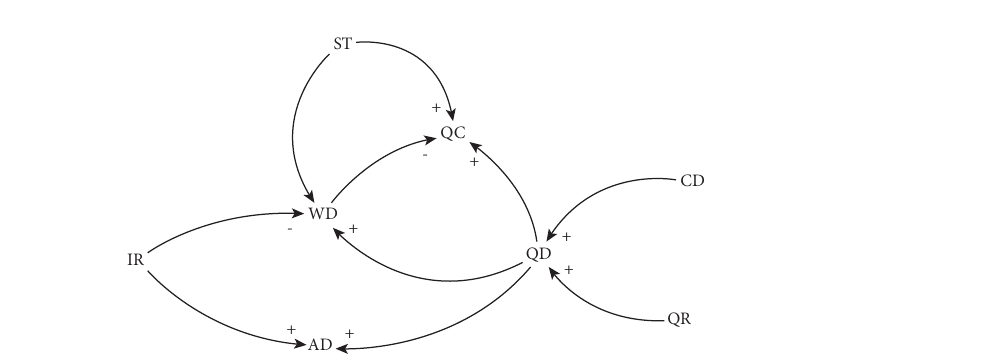
Figure 2: Causal relationship of quarantine subsystem. Table 2: Definition of parameters in Figure 2.